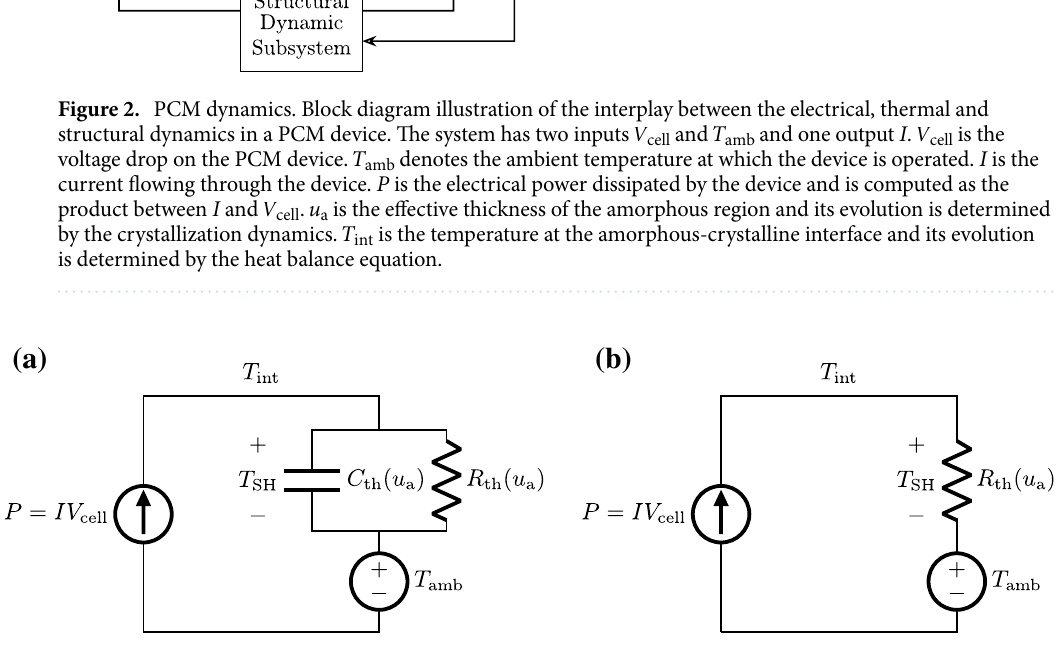
Figure 3. Thermal subsystem. ( a ) First order circuit model that takes into account the presence of C th ( u a ) (see Eq. (1)). ( b ) The simplified circuit model can be employed as described by Eq. (2) when the write pulse duration is substantially higher than τ th